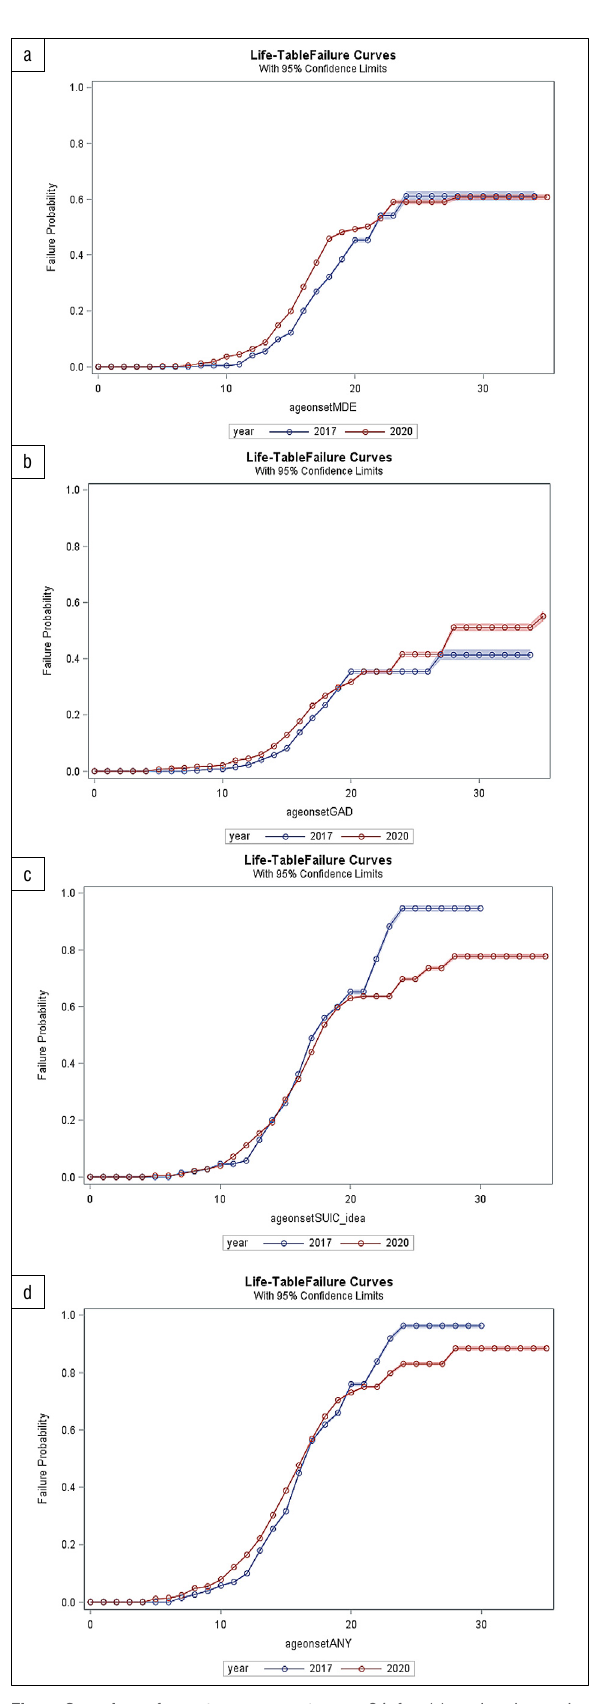
Figure 1: Age of onset curves up to age 22 for (a) major depressive episode (MDE), (b) generalised anxiety disorder (GAD), (c) suicidal ideation, and (d) any of these outcomes among first- year students at Stellenbosch University in 2015, 2017 and 2020.